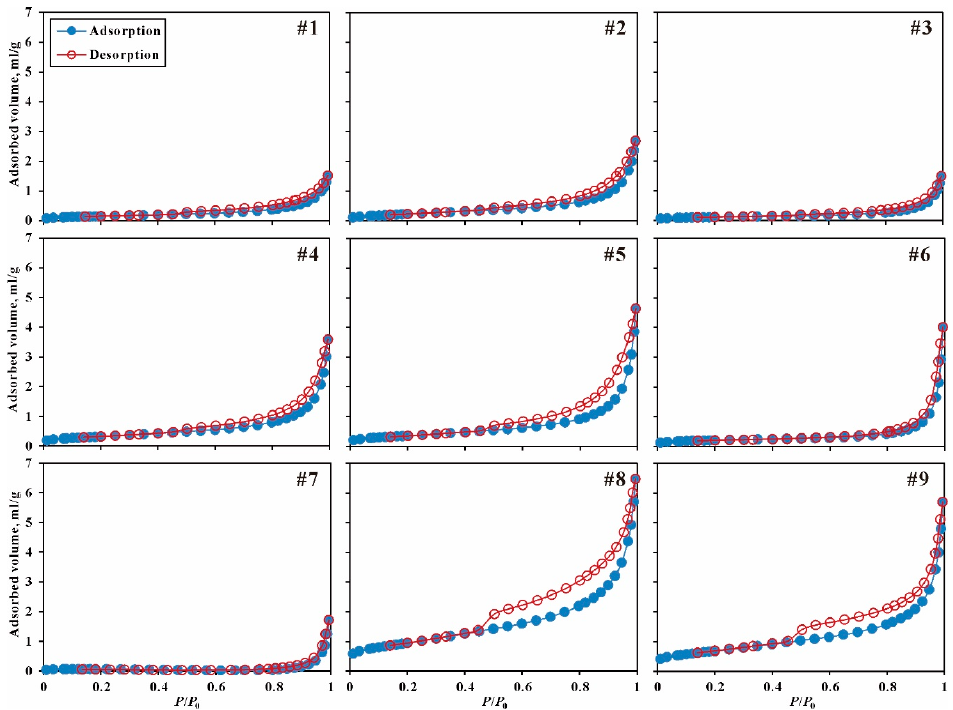
Figure 5. Nitrogen (N 2 ) adsorption–desorption isotherms of nine tight rock samples in the Xujiaweizi Rift.